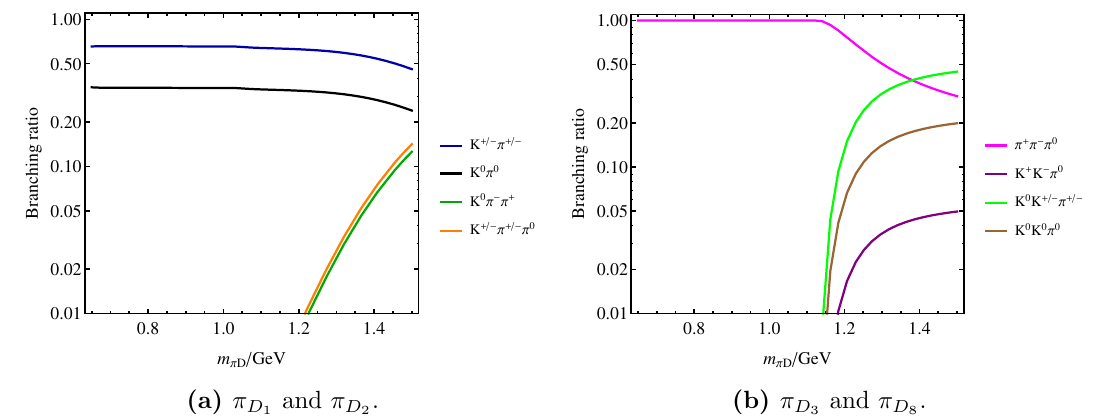
(b) (cid:25) D 3 and (cid:25) D 8 . Figure 2. Branching ratios of the dark pions (cid:25) D 1 and (cid:25) D 2 , and (cid:25) D 3 and (cid:25) D 8 , for an \aligned" coupling matrix (cid:20) = (cid:20) 0 1 3 3 . The remaining dark pions, (cid:25) D 4 , (cid:25) D 5 , (cid:25) D 6 and (cid:25) D 7 decay via a loop (cid:2) and/or additional SM (cid:13)avour breaking, and will be